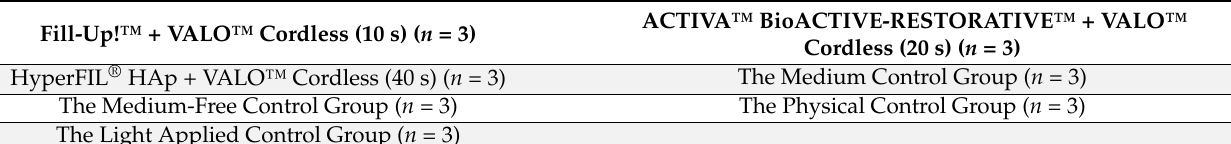
Table 2. The study design of the experimental and the control groups prepared in well plates. ACTIVA™ BioACTIVE-RESTORATIVE™ + VALO™ Fill-Up!™ + VALO™ Cordless (10 s) ( n = 3) Cordless (20 s) ( n = 3) HyperFIL ® HAp + VALO™ Cordless (40 s) ( n = 3) The Medium Control Group ( n = 3) The Medium-Free Control Group ( n = 3) The Physical Control Group ( n =